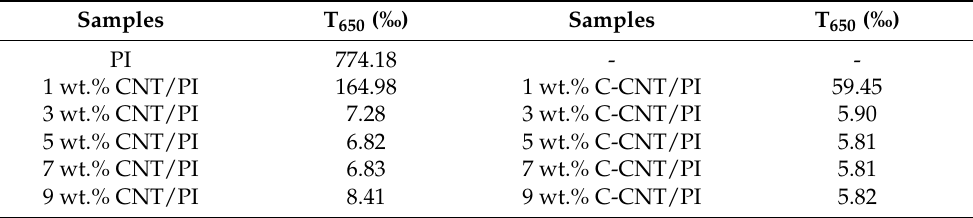
Table 4. Transmittance of PI, CNT/PI and C-CNT/PI